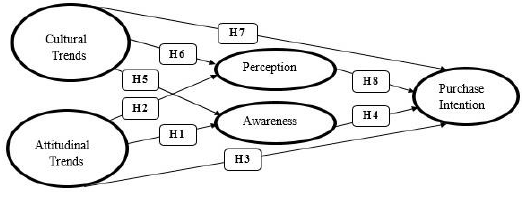
Figure 1. Conceptual Model of the